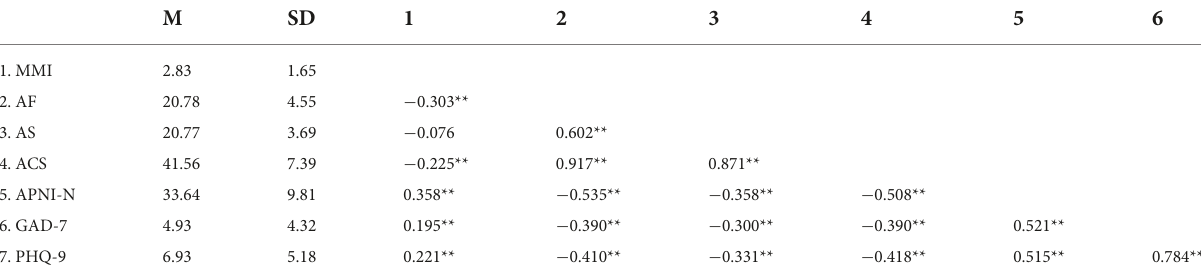
TABLE 1 Mean, standard deviation, and correlation coefficient of each variable.